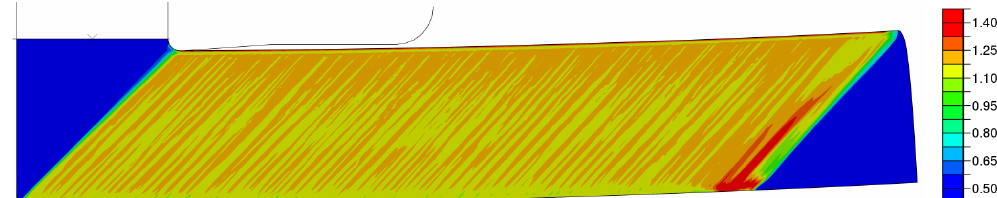
Figure 4. Contour plot of the effective plastic strain s (cf. Equation (9)) for the reference simulation: some inhomogeneities are visible. Compared to experimental observations of shear and matrix bands, these variations are negligible; they are therefore considered as minor